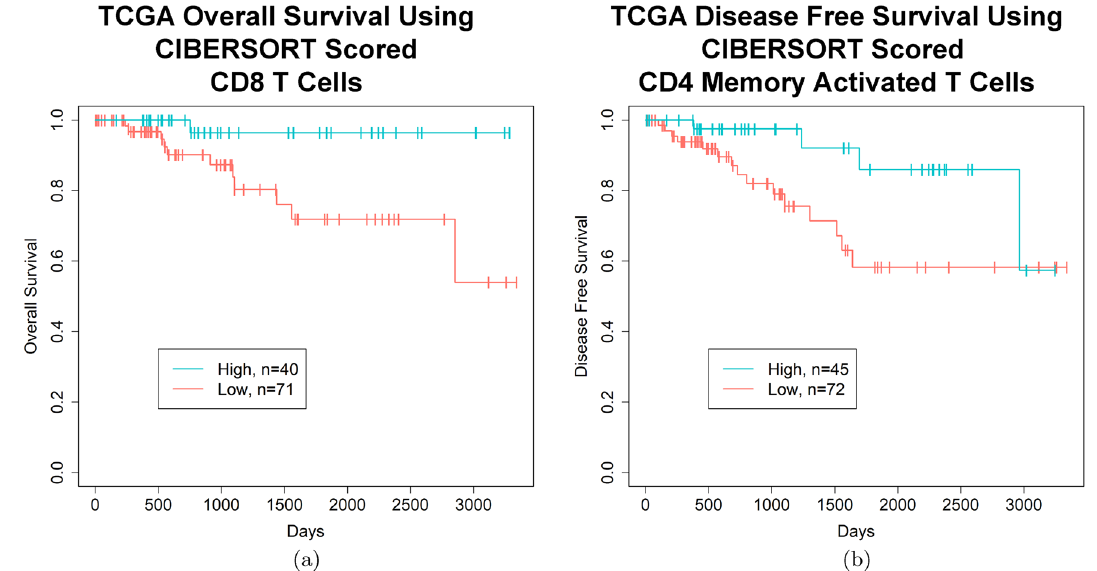
Figure 4. Kaplan–Meier curves demonstrating improvements in OS or DFS in TCGA TNBC patients with high quantities of CD8 T cells or CD4 memory activated T cells in their tumor sample, respectively. ( a ) TCGA TNBC patients with a higher proportion of CD8 T cells in their tumor have a better OS (p = 0.013, FDR = 0.24, log rank test) (survival rates high vs. low, 5 year: 96.4% and 71.9%, 10 year: 96.4% and 53.9%). ( b ) TCGA TNBC patients with a higher proportion of CD4 memory activated T cells in their tumor sample have a better DFS (p = 0.034, FDR = 0.66, log rank test) (survival rates high vs. low, 5 year: 85.9% and 58.2%, 10 year: 57.3% and 58.2%). ( a ) and ( b ) High and low cut offs of T cell infiltrate were chosen as quantities above and below 0.25 times the standard deviation of the mean, respectively. ( a ) and ( b ) Images generated with R 4.0.2 (https :// www.R-proje ct.org) 35